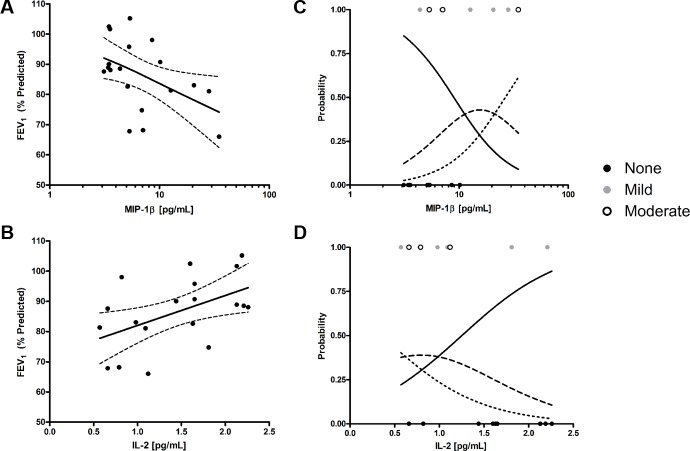
Asthmatic phenotypes have markers of increasing severity that is associated with MIP-1β and IL-2.Linear regression of (A) MIP-1β and (B) IL-2 associations with FEV1 (% predicted). Ordinal logistic regression of (C) MIP-1β and (D) IL-2 predicting type of obstruction: none or no obstruction (solid), mild obstruction (FEV1 (% predicted) > 70%) (dashed), moderate obstruction (FEV1 (% predicted) < 70%) (dotted). Solid and dashed lines for all graphs depict trend lines and 95% confidence intervals, respectively. All models were univariate. P < 0.05 was considered significant for the whole model and linear predictor.